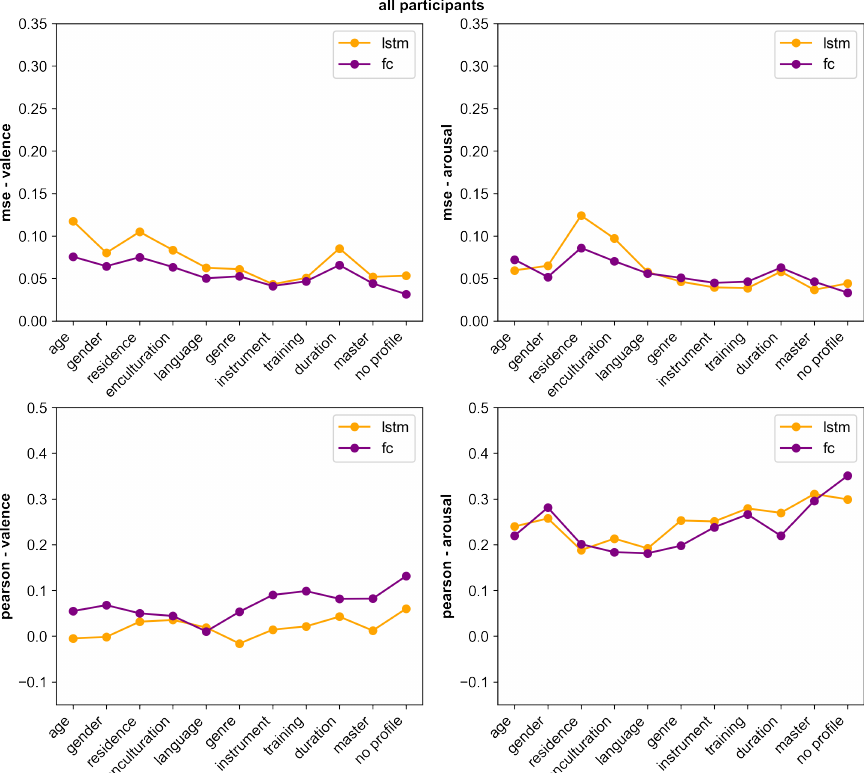
Figure 7. Comparison of evaluation metrics between the models trained using different profile features. Note that the range of the y-axes of the graphs has been adjusted for viewing